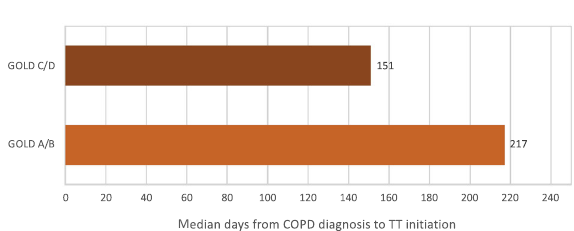
Fig. 2 Median time from COPD diagnosis to TT according to GOLD subgroups for patients who initiate triple therapy at or after diagnosis of COPD. COPD : chronic obstructive pulmonary disease; TT : triple therapy; GOLD : global strategy for obstructive lung